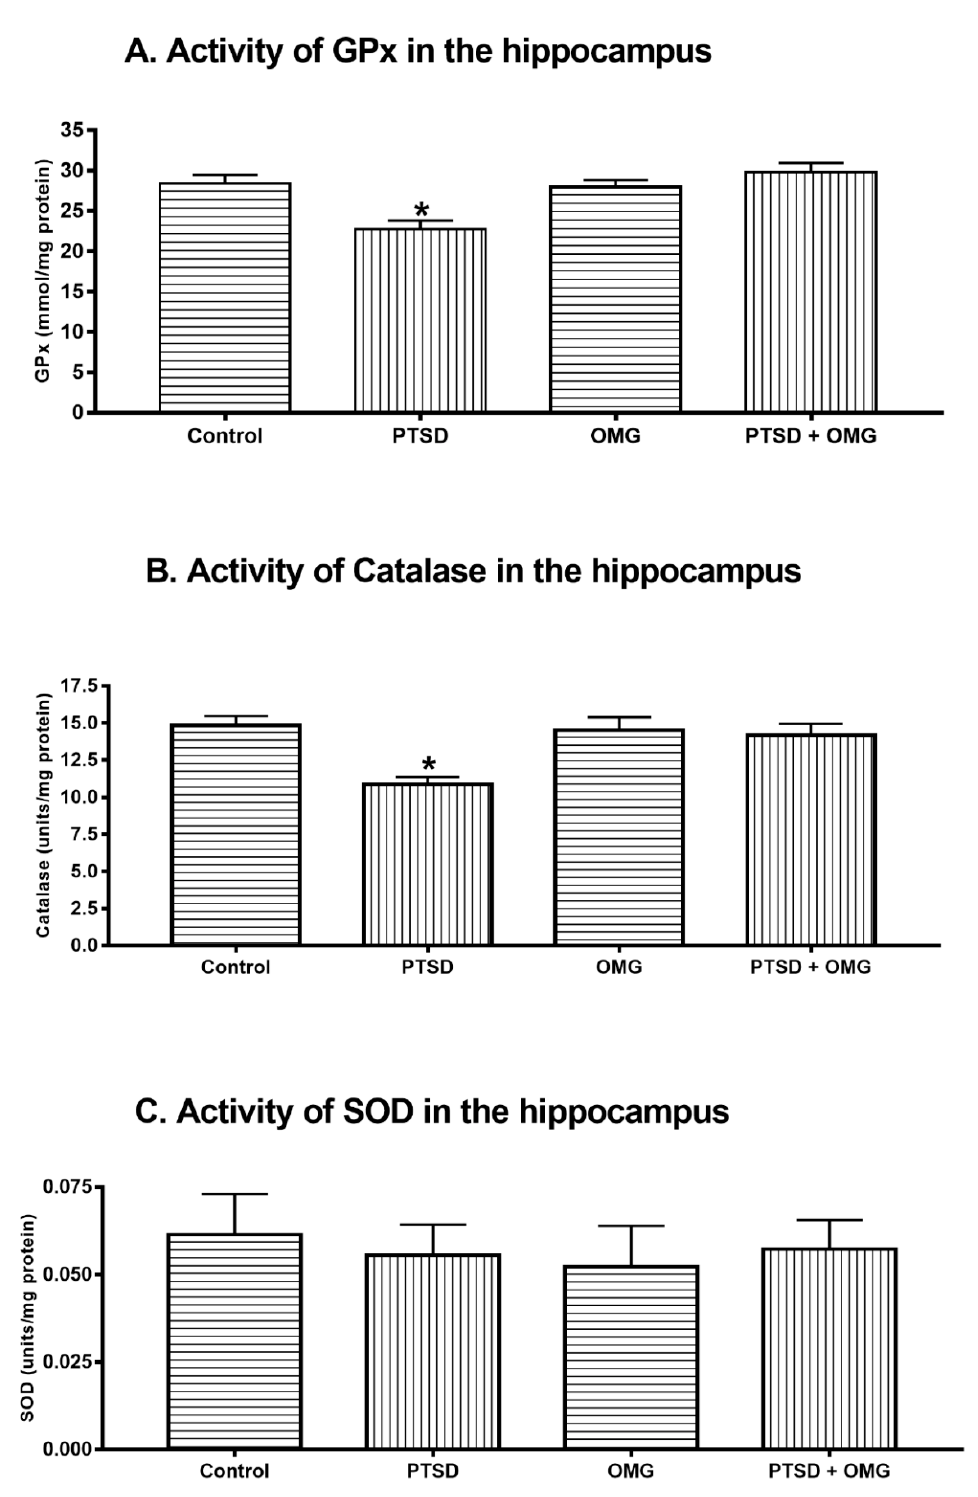
Figure 4. Effect of omega-3 and/or SPS model of PTSD on the activity of anti-oxidative stress enzymes in the hippocampus. ( A ) Hippocampal GPx activity, ( B ) hippocampal catalase activity, and ( C ) hippocampal superoxide dismutase (SOD) activity among control, post-traumatic stress disorder (PTSD), omega-3 treated animals (OMG), and PTSD treated with OMG (PTSD + OMG) groups. * Indicate significant difference relative to other groups ( p < 0.05). Each point is the mean ± SEM of 15 rats.